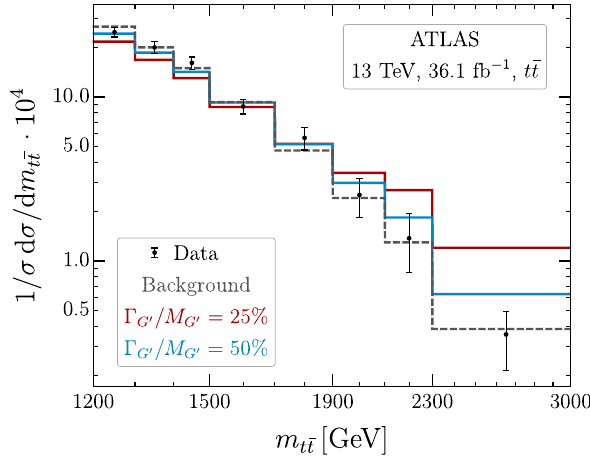
Fig. 8 Illustration of the coloron signal in the ditop final state for M G (cid:2) = 2 . 5 TeV, κ ll q = 0, and two reference values for the width, compared to the data from [47]